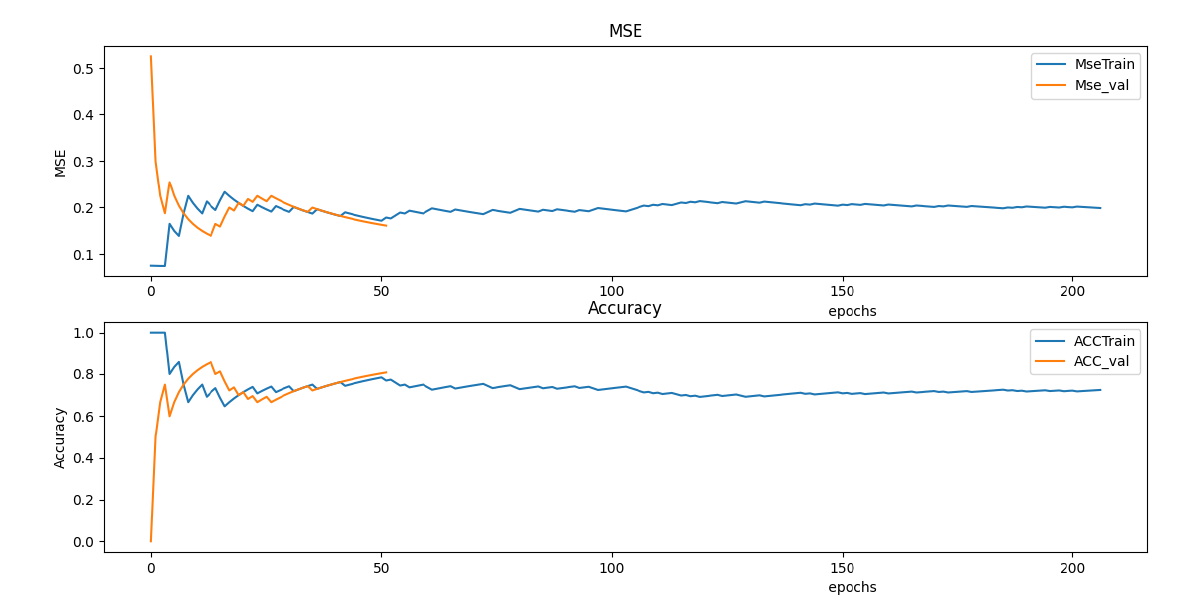
Figure 2. Machine learning algorithm shows increased accuracy and decreased MSE values over the first 50 training rounds (ie, epochs) for predicting MQOL through EWB ( a ccuracy: 0.80, MSE: